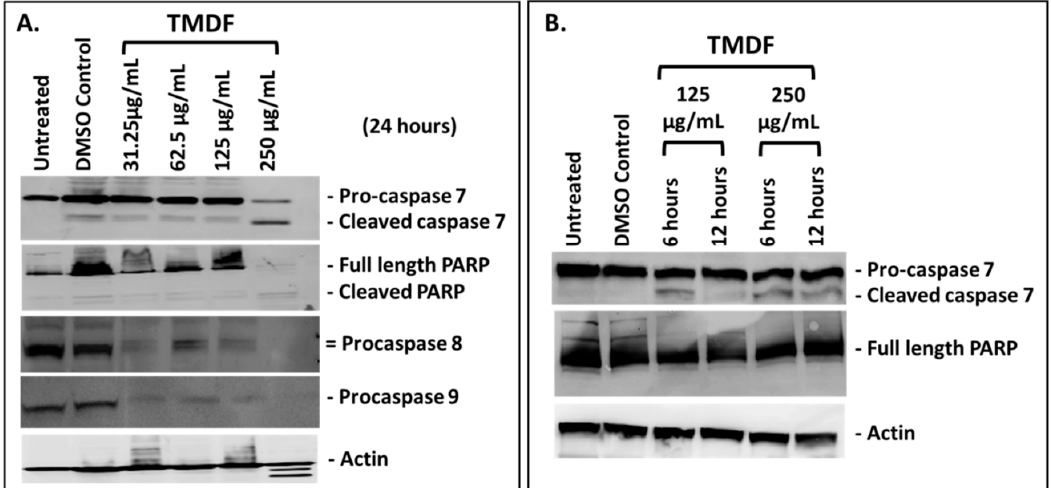
Figure 2. Western blot analysis of MCF-7 cells treated with the dichloromethane fraction of T. mascatense (TMDF): ( A ) for 24 h, ( B ) for 6 and 12 h at the indicated concentrations followed by detection of